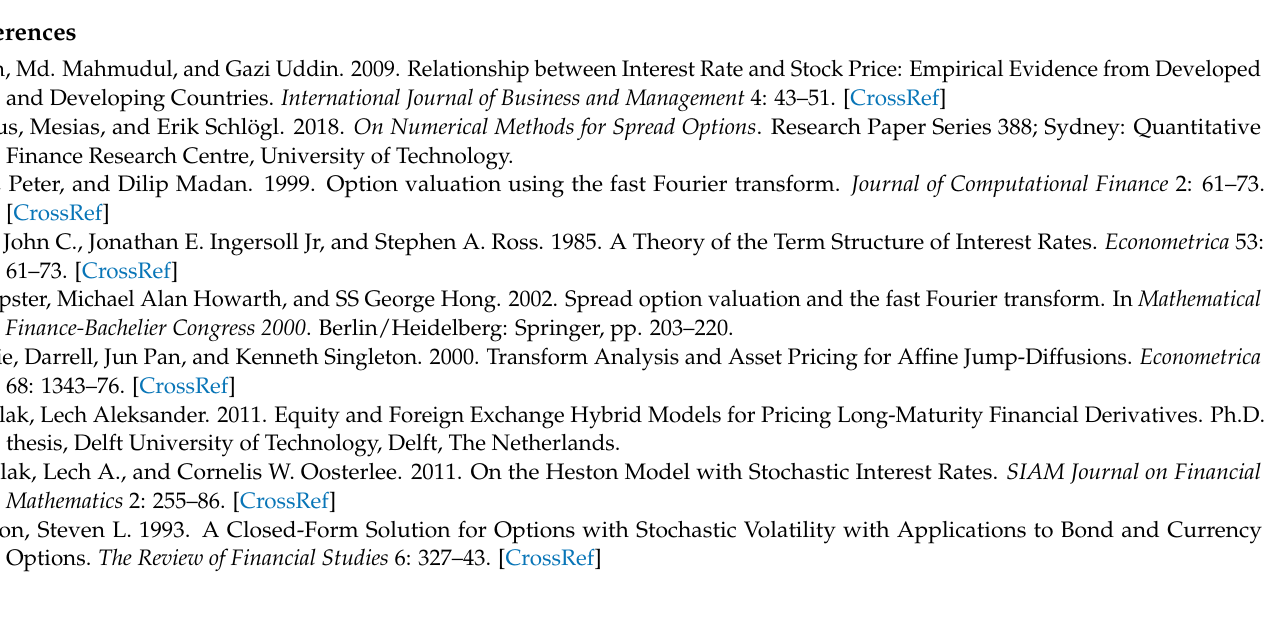
Figure 3. Impact of stochastic interest rates with η = 0.05, ρ x